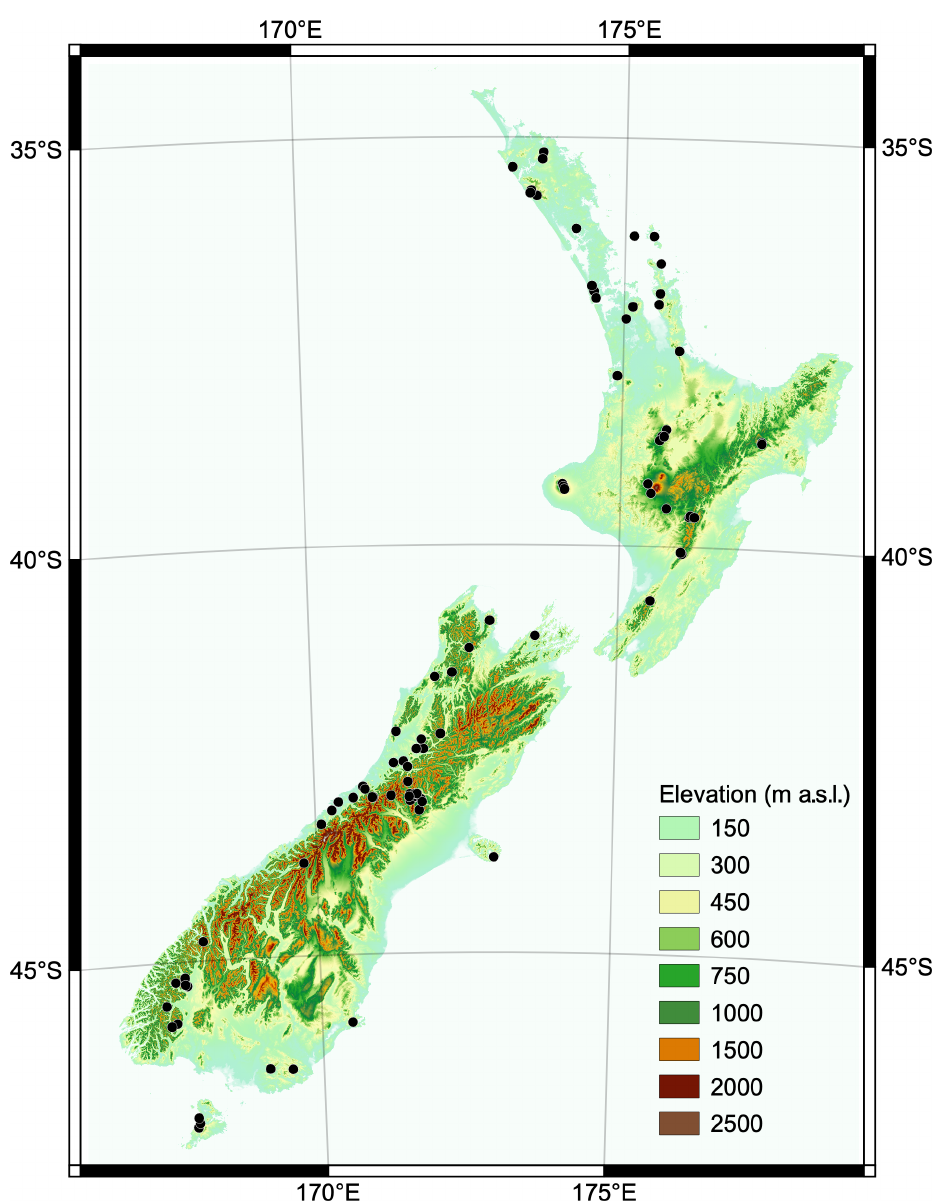
Figure 1. Distribution of tree-ring chronologies in New Zealand. Elevation data sourced from the LINZ Data Service and licensed for reuse under CC BY